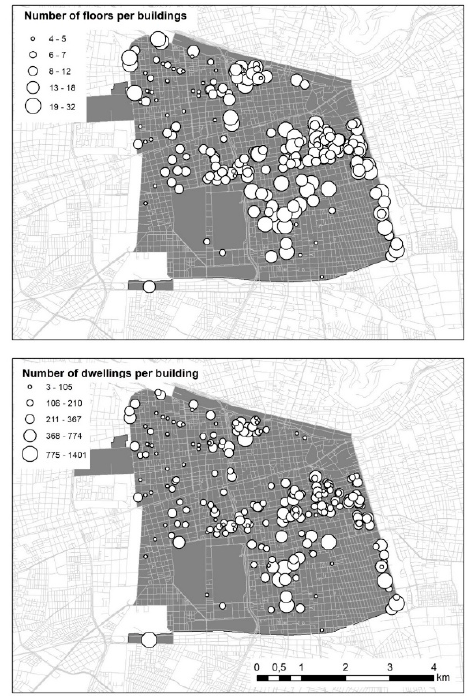
Figure 4. New buildings in Santiago. In red, the number of floors; in green, the number of new housing units. Source: prepared and mapped by authors based on the National Institute of Statistics.